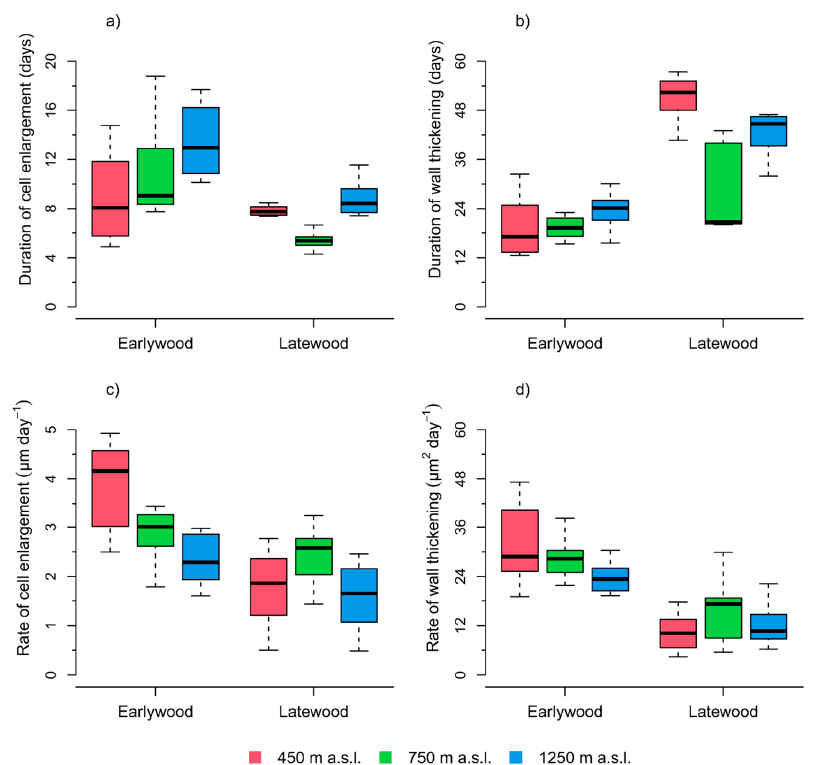
Figure 4. Boxplots of ( a ) the durations of cell radial enlargement, ( b ) durations of wall thickening, ( c ) rate of radial cell enlargement, and ( d ) rate of wall thickening for earlywood and latewood tracheids of the 450 m, 750 m, and 1250 m a.s.l. elevation sites, respectively. The boundary for grouping earlywood and latewood cells was based on the irreversible transition of the Mork’s Criterion > 1 (see Figure 3).